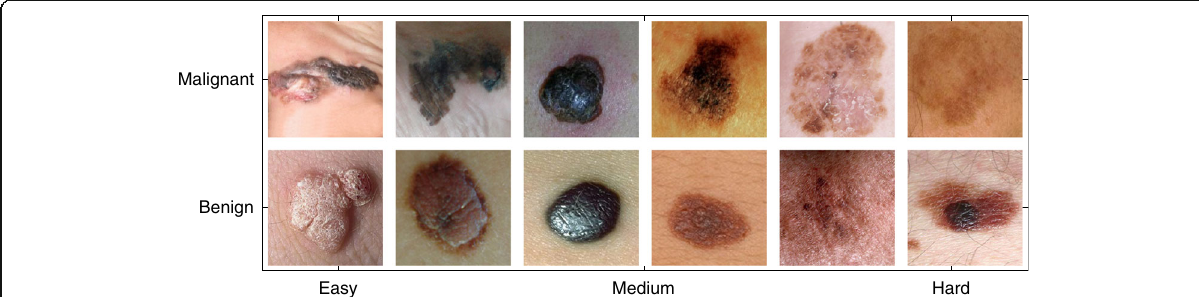
Fig. 3 A set of images demonstrating the spectrum of difficulty for the two classes of skin lesions. The first and second row show malignant and benign skin lesions, respectively. Within each row, the items on the left are predicted to be the easiest while the items on the right are predicted to be the